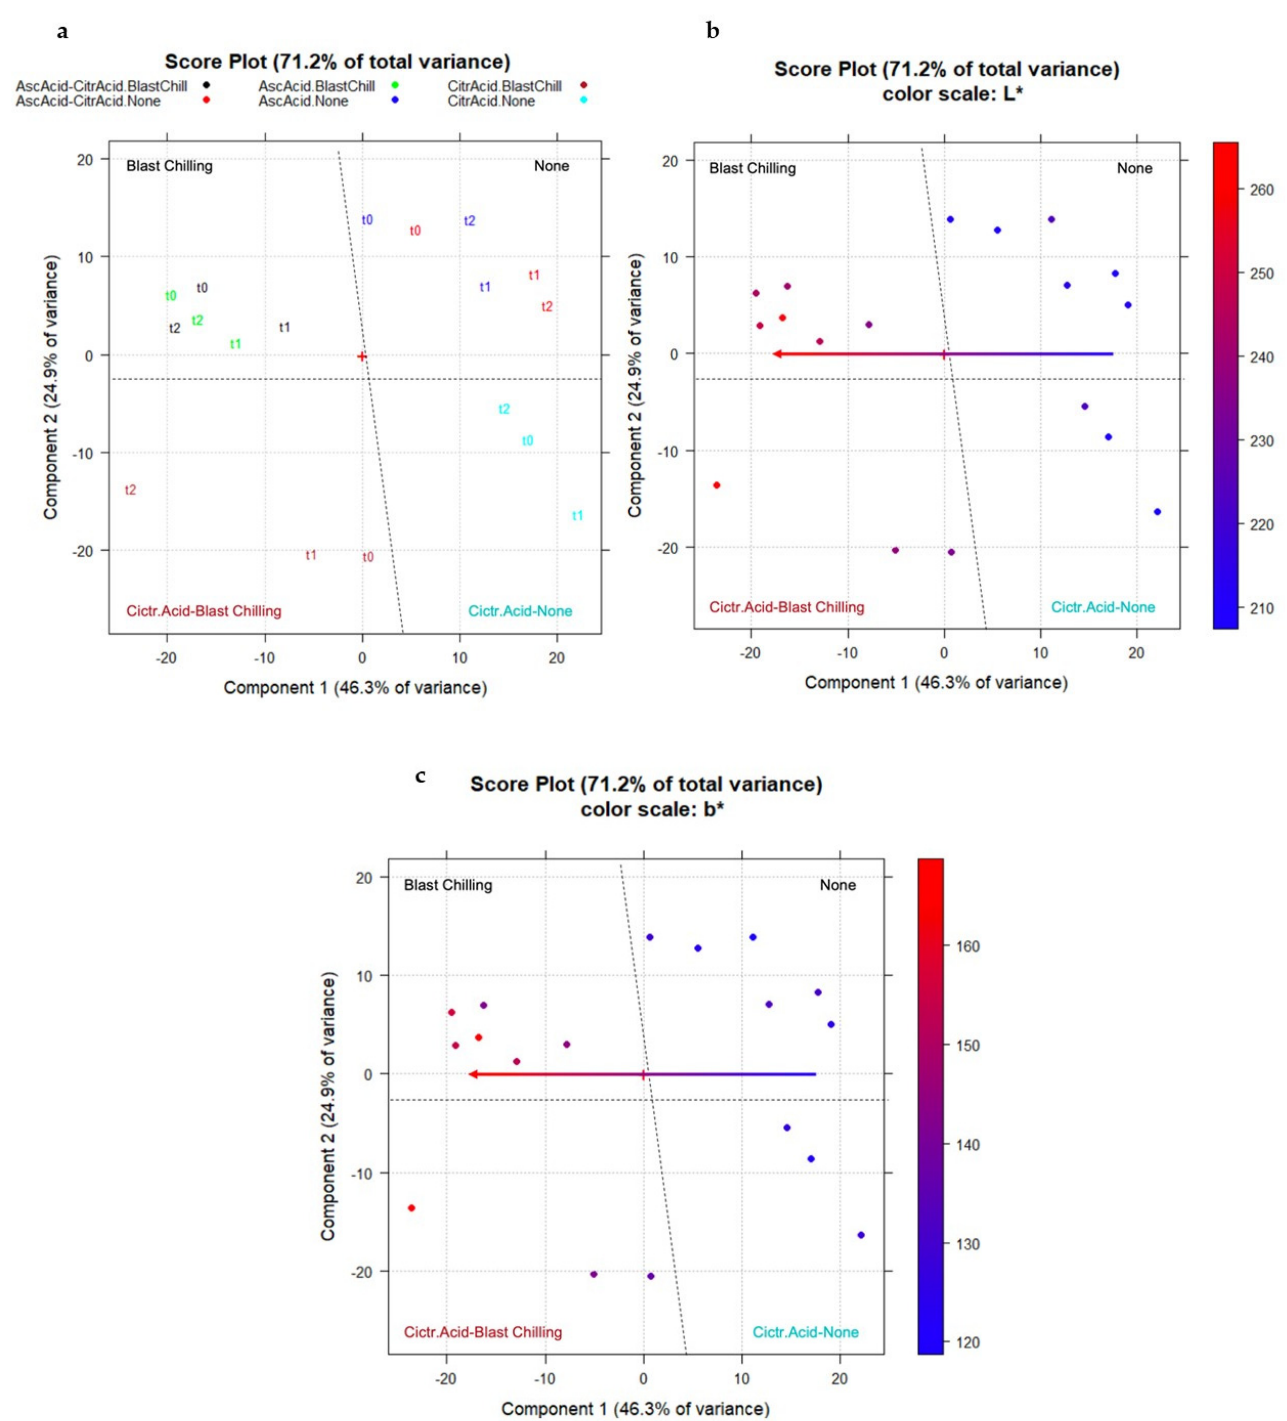
Figure 6. The score plot PC1–PC2 of data matrix B 18,521 . ( a ) The objects were coded according to the time point (t0, t1, and t2) and colored according to the different additive used in the formulation (ascorbic acid, citric acid, or the mixture of ascorbic acid and citric acid); ( b ) the correlation between the L* coordinate (lightness) and PC1 scores is highlighted; ( c ) the correlation between the b* coordinate (bluish–yellowish) and PC1 scores is highlighted. From the score plot of data matrix B 18,521 in the plane PC2–PC3 (46.1% total variance explained), with the objects coded according to the time point (t0, t1, and t2), and colored